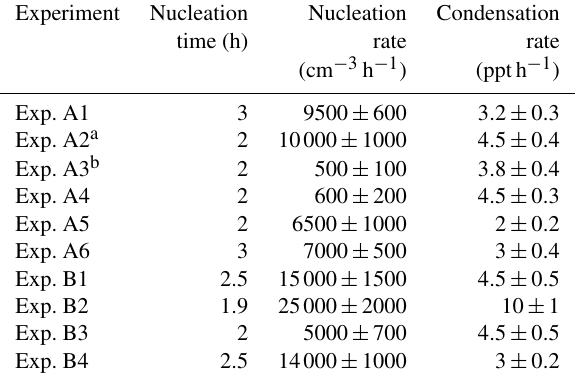
Table 3. Nucleation time, nucleation rate, and condensation rate in the experiments that NPF was observed in the perturbed